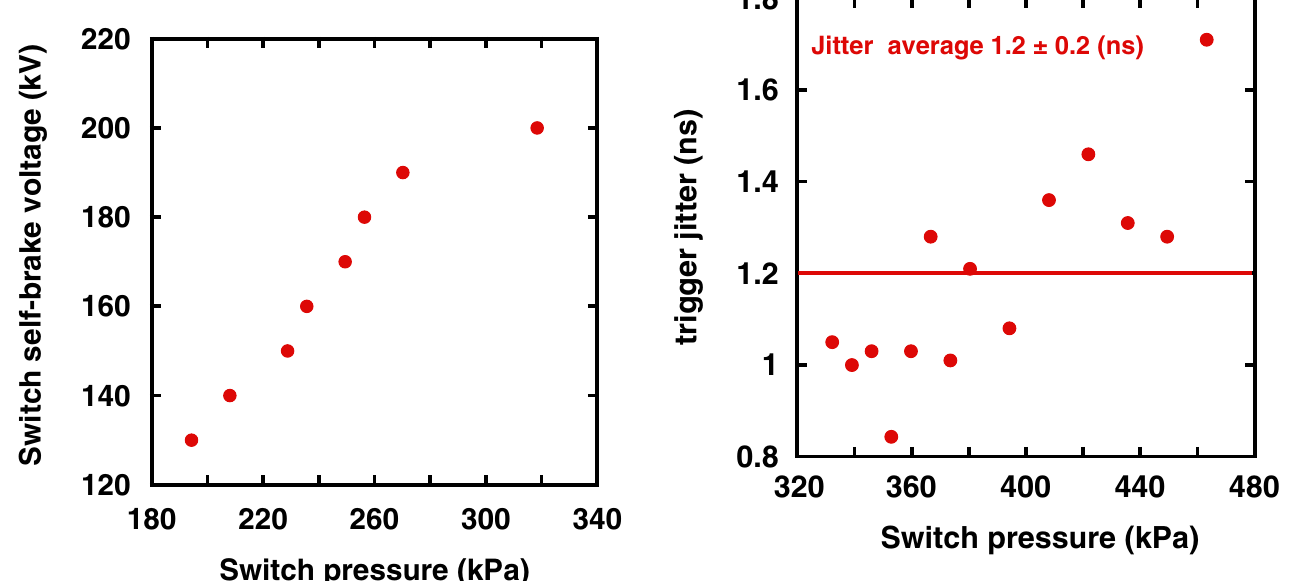
FIG. 15. (Color) Switch closure variation (jitter) for the switch pressure range studied.